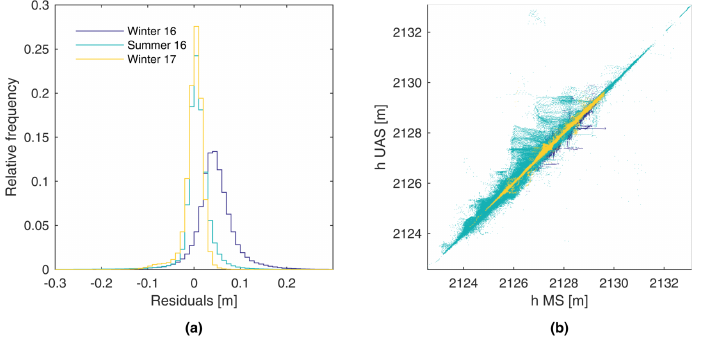
Figure 4. Histograms of the residuals between the MultiStation scan and the DSM from UAS data (C2) for each of the three surveys ( a ). Scatter plot of UAS-based vs. MS-based heights (ASL) for both winter and summer cases ( b